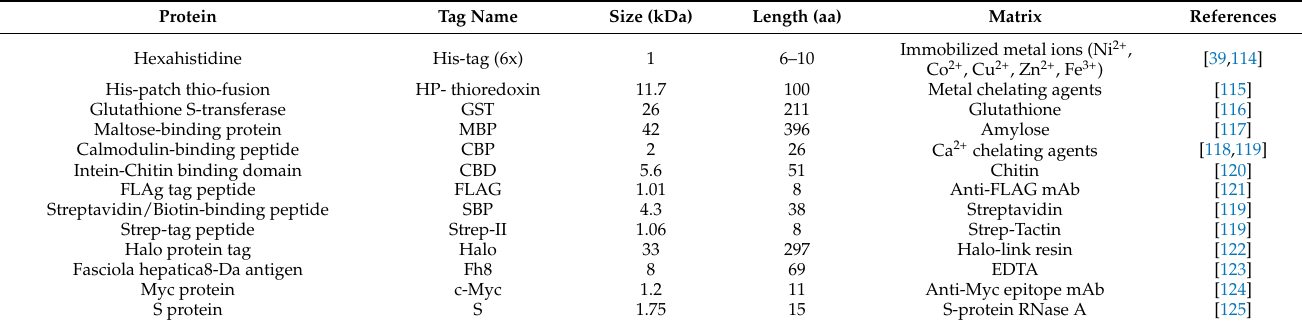
Table 2. Common fusion tags for recombinant protein